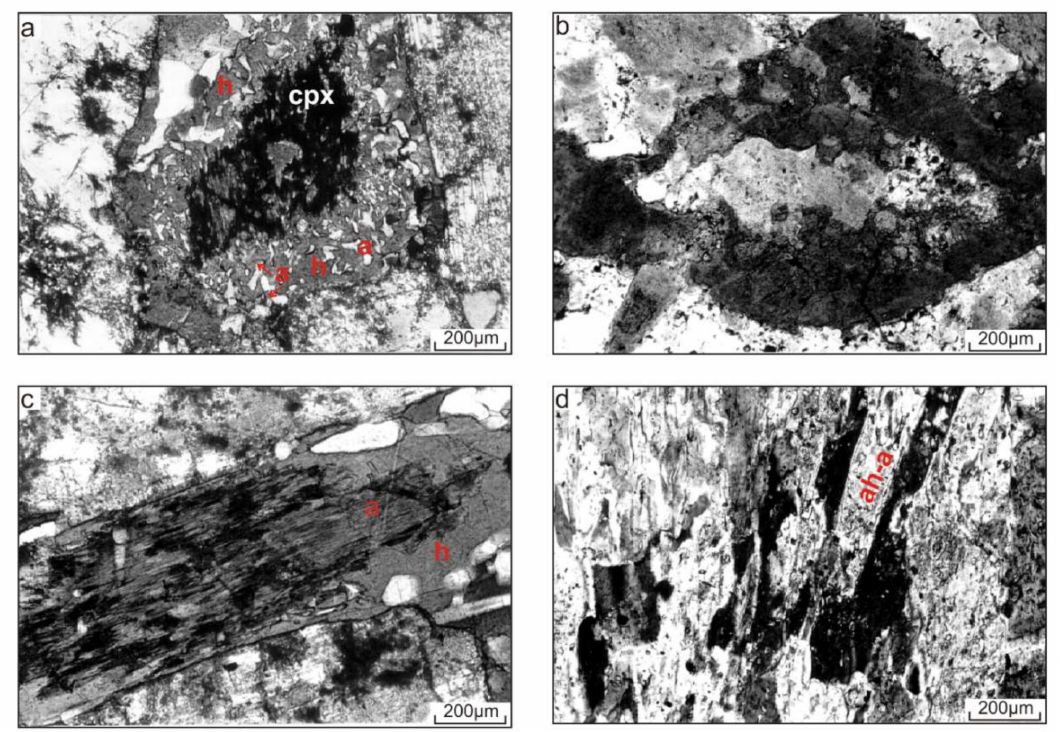
Figure 4. Petrographic microscope photomicrographs illustrating the textural relationships in the amphiboles. a: actinolite; ah: actinolitic hornblende; cpx: clinopyroxene; h: hornblende. Each field of view is approximately 2.5 mm. ( a ) Altered clinopyroxene forming the core of an olive-green to pale brown hornblende. Actinolite vermicules radiate from the core. High-Ti hornblende gabbro 2946, crossed polars. ( b ) Amphiboles with hollow cores. Pegmatitic hornblendite 2653, plane-polarised light. ( c ) Amphibole crystal with core of fibrous actinolite (pseudomorphing clinopyroxene) rimmed by olive-green hornblende. High-Ti hornblende gabbro 2946, plane polarised light. ( d ) Actinolite with twins or inclusions of actinolitic hornblende–actinolite. Pegmatitic hornblendite 2653, crossed polars (cf. analyses 13–15, Table